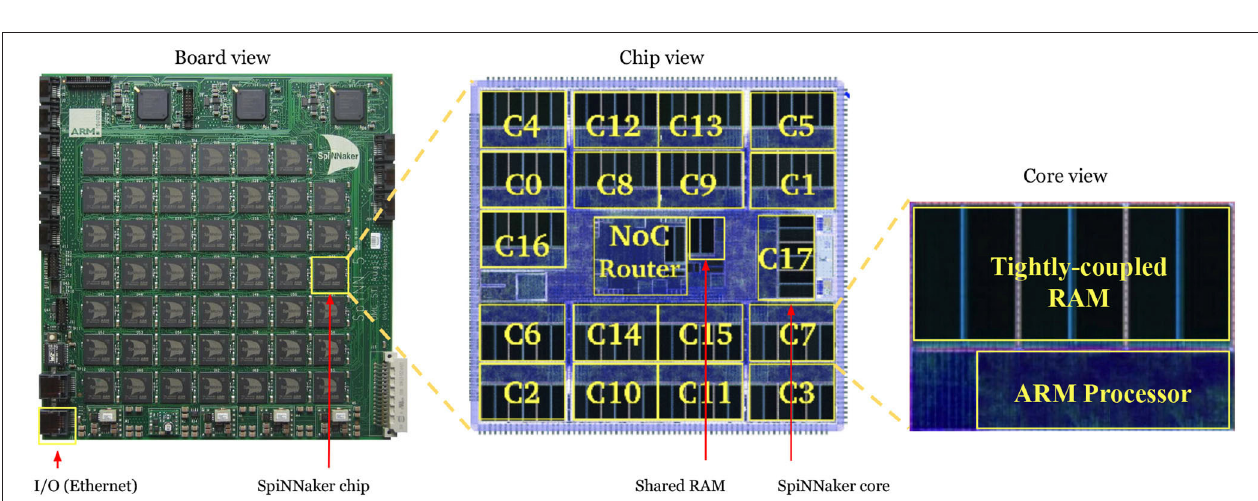
FIGURE 1 | Overview of the LSM architecture for a 2-dimensional temporal input (visualized here as frames) mapped to a 1-dimensional spiketrain. Values of N input neurons and M hidden neurons are smaller than those used in this work, for simplification. Gray shaded area indicates non-trainable synaptic weights and purple shaded area indicates trainable weights.